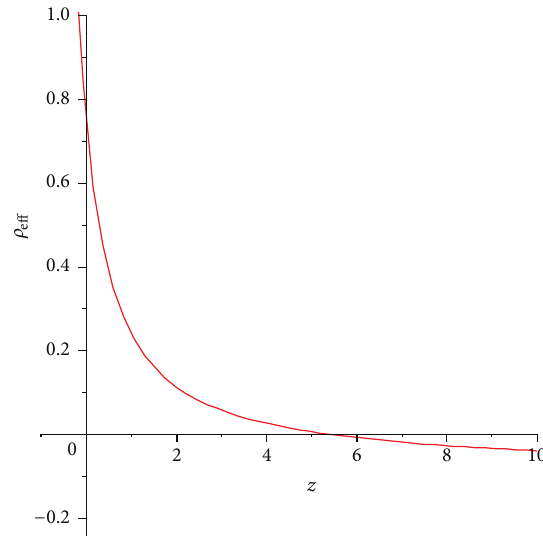
Figure 2: Variation of effective energy density versus the redshift for a specific 𝑓(𝑅) model described as (33) with 𝑛 = 0.25